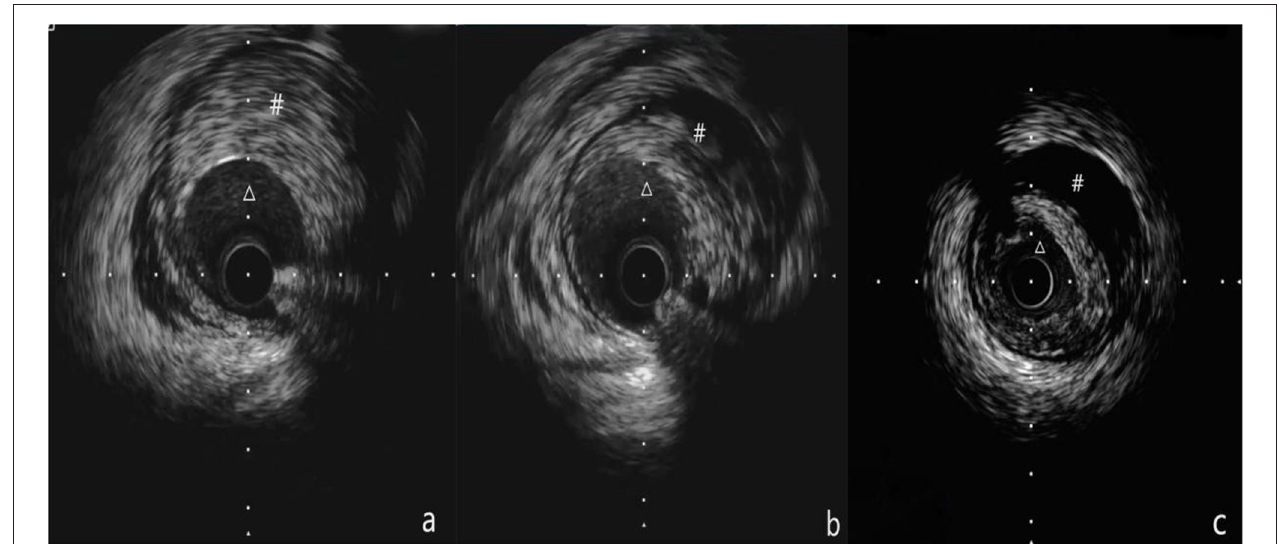
FIGURE 2 | (a-c) Show the process of IVUS examination from the distal part to the proximal part of the blood vessel. (a) Shows that 1 is the true lumen of the blood vessel, # is intramural hematoma, (b) Shows that 1 is the true lumen of the blood vessel, # is the intramural hematoma, and (c) shows that 1 is the true lumen of the blood vessel, # is an intramural hematoma. (a-c) Show the pulling process of the IVUS catheter from far to near, showing that the guide wire travels under the intima in the middle of the blood vessel, but returns to the true lumen at the far